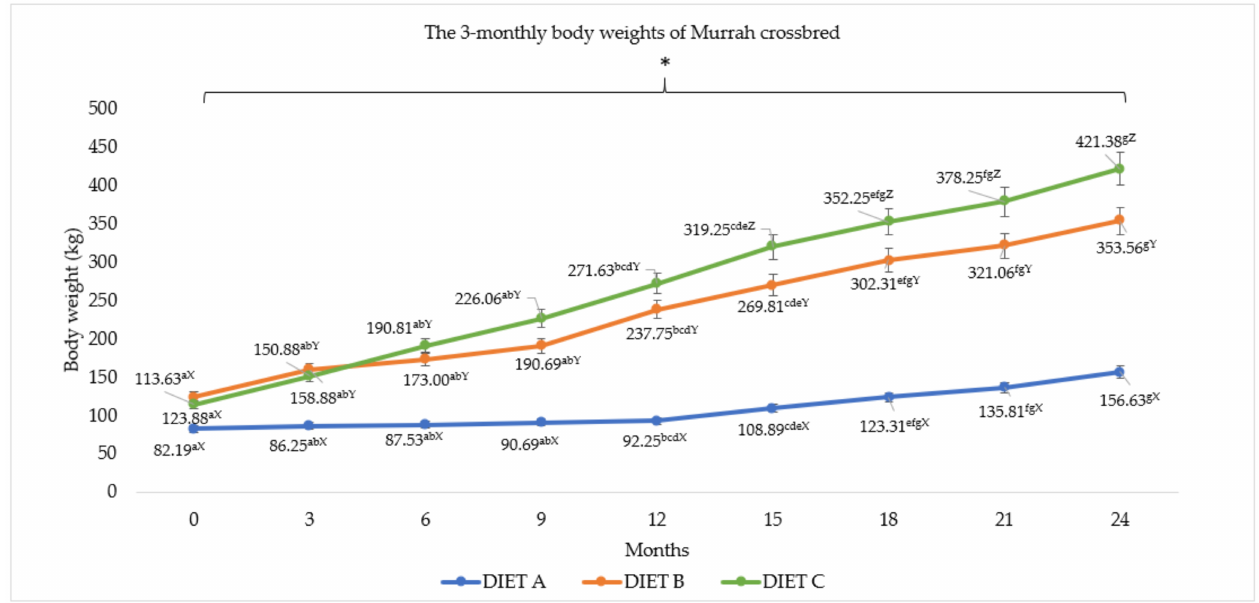
Figure 3. The three-monthly body weight (Mean ± SEM) of Murrah cross. Diet A (control)—(100% Brachiaria decumbens) ; Diet B—(70% Brachiaria decumbens + 30% concentrate); Diet C—(70% Brachiaria decumbens + 26% concentrate + 4% bypass fat); the values are presented as mean; a,b,c,d,e,f,g different superscripts indicate significant difference of three-monthly body weight of Murrah crossbred buffalo for each Diet A, B, and C at p < 0.05; X,Y,Z different superscripts indicate significant difference between Diet A, B, and C for each three month interval of feeding at p < 0.05; * indicating significant ( p < 0.05) difference comparing body weight and